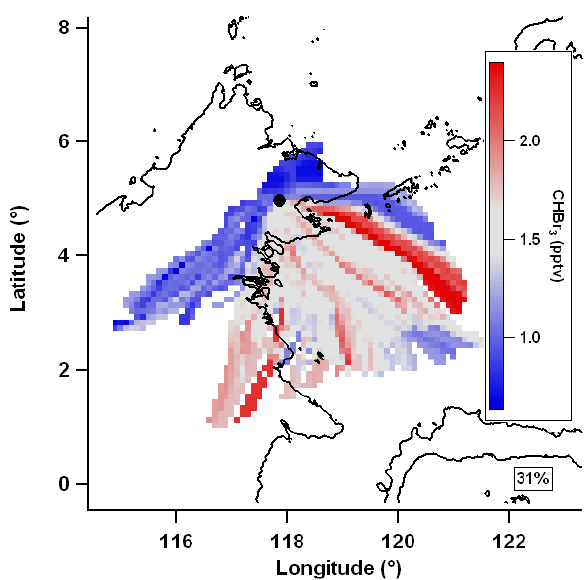
Fig. 2. Example mean value map of bromoform (CHBr 3 ) during OP3-III using 36h trajectories. Grey is median value, red is greater than median, blue is less than median and white denotes no data coverage. Percentage of trajectories used denoted below key.